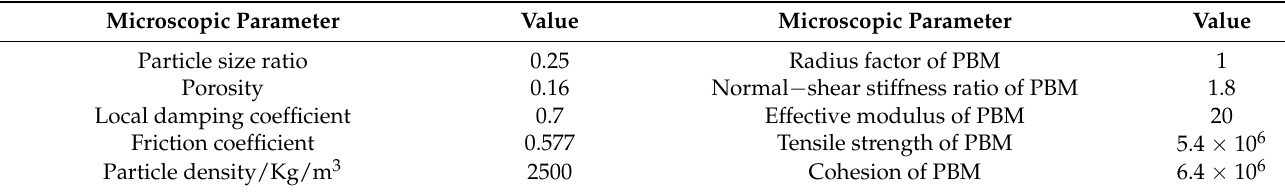
Table 2. Meso mechanical parameters of calculation